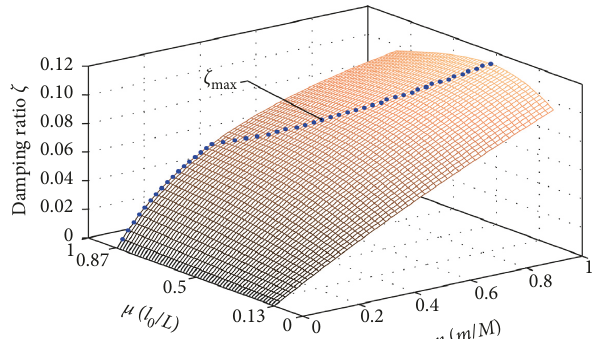
Figure 7: The effects of η and μ on the equivalent damping ratio ζ and the maximum damping ratio ζ max